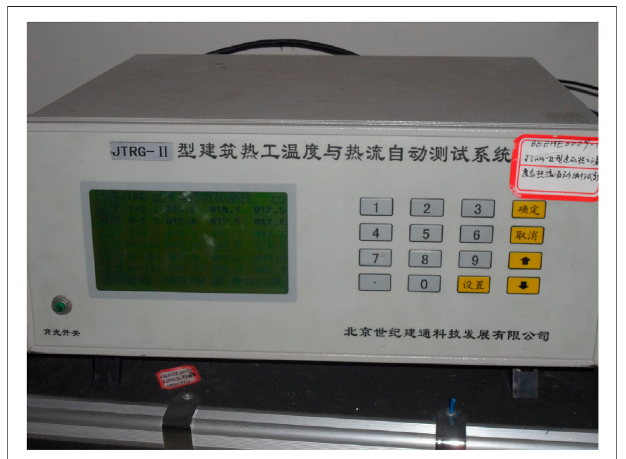
FIGURE 4 | JTRG- Ⅱ automatic test system.